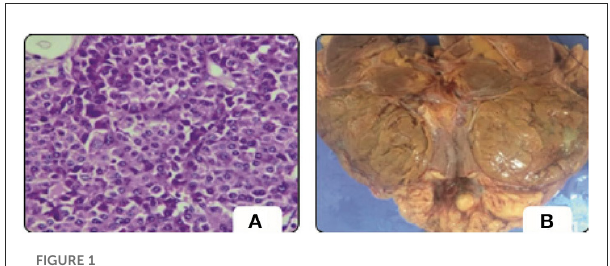
FIGURE1 Oncocytoma. (A) Microscopy. (B) Cut surface (5).